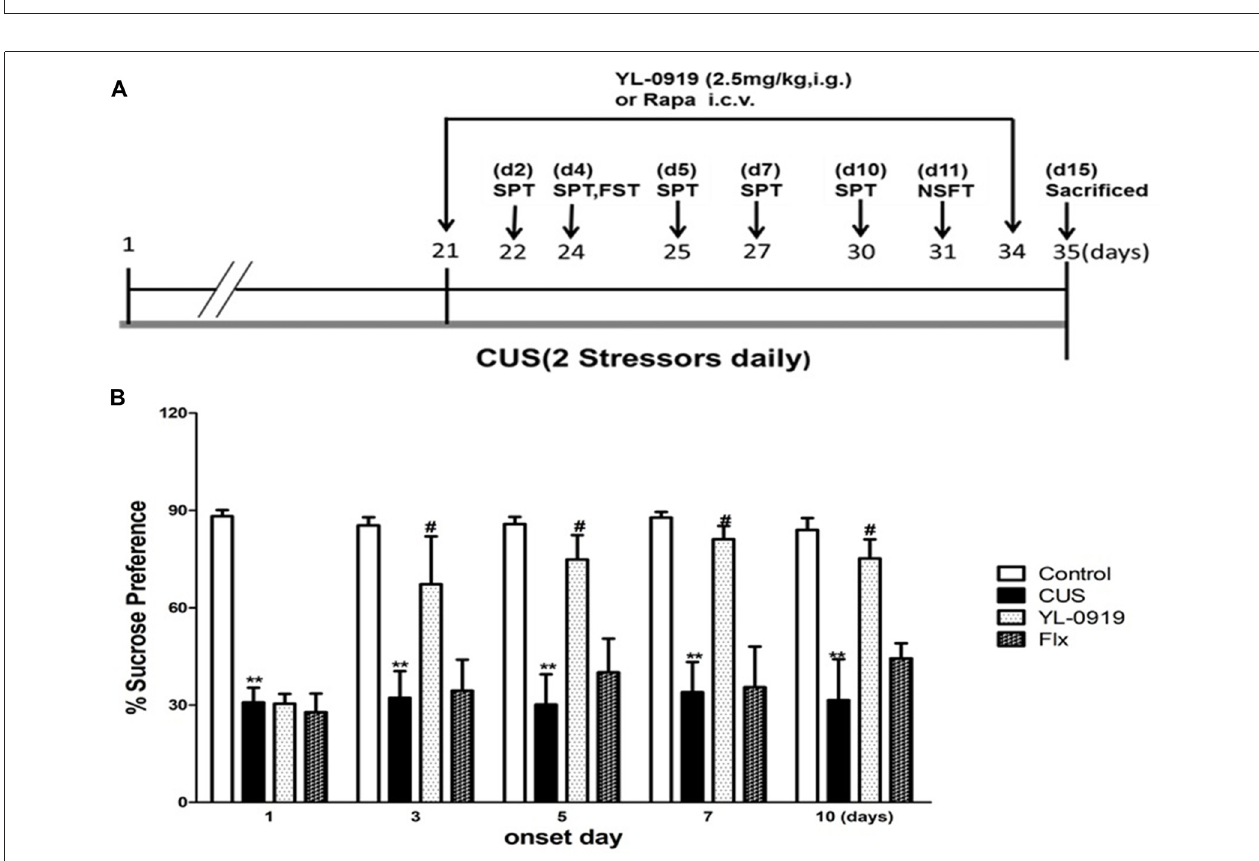
FIGURE 2 | (A) YL-0919 induced rapid anti-depressant responses in a chronic unpredictable stress (CUS) paradigm. Schematic drawing demonstrating the timeline for CUS exposure, drug administration and behavioral testing. Numbers in parentheses represent days after drug administration. Rats were exposed to CUS for 35 days and administered YL-0919 (2.5 mg/kg, i.g.) or Flx (10 mg/kg, i.g.) from day 21 onwards and lasting for 14 days. (B) Effects of YL-0919 on CUS-induced depressive-like behavior in rats assessed by Sucrose Preference Test (SPT) on day 1, 3, 5, 7 and 10 after drug administration. n = 8; ∗∗ ,# P < 0.05 compared